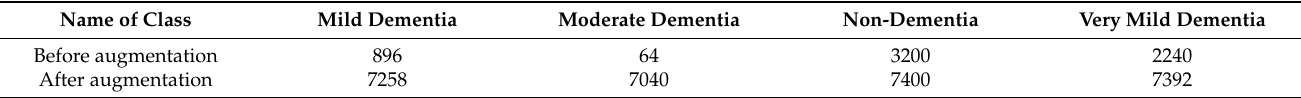
Table 5. The data augmentation technique to balance the MRI dataset during the training phase.